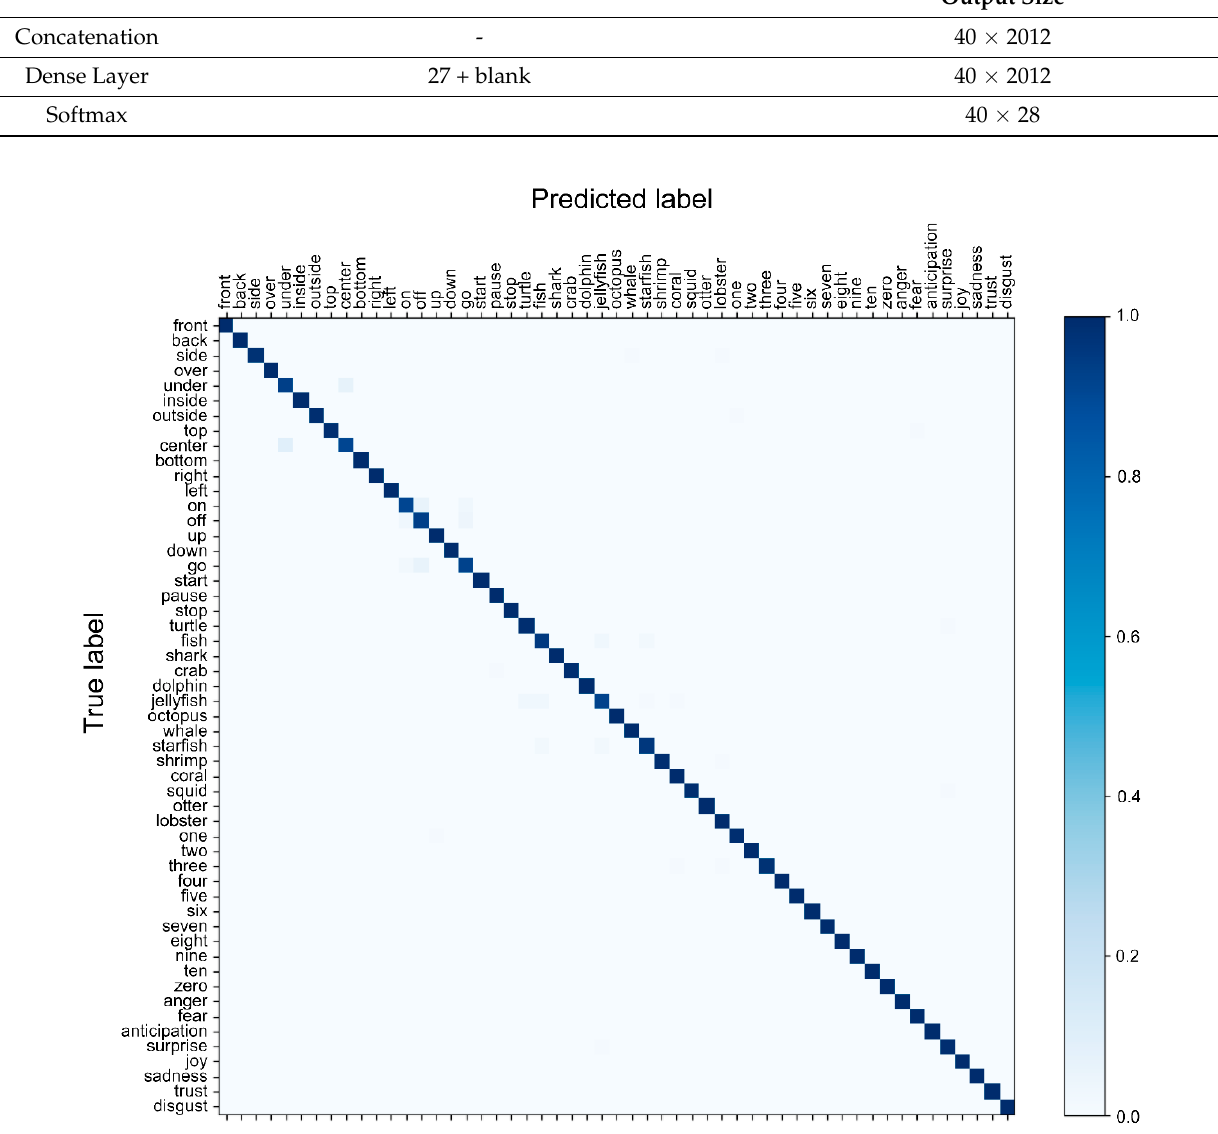
Figure A1. Confusion matrix of the proposed model trained on 53 classes. Table A2. Average word accuracy and standard deviation of the proposed system in four noise